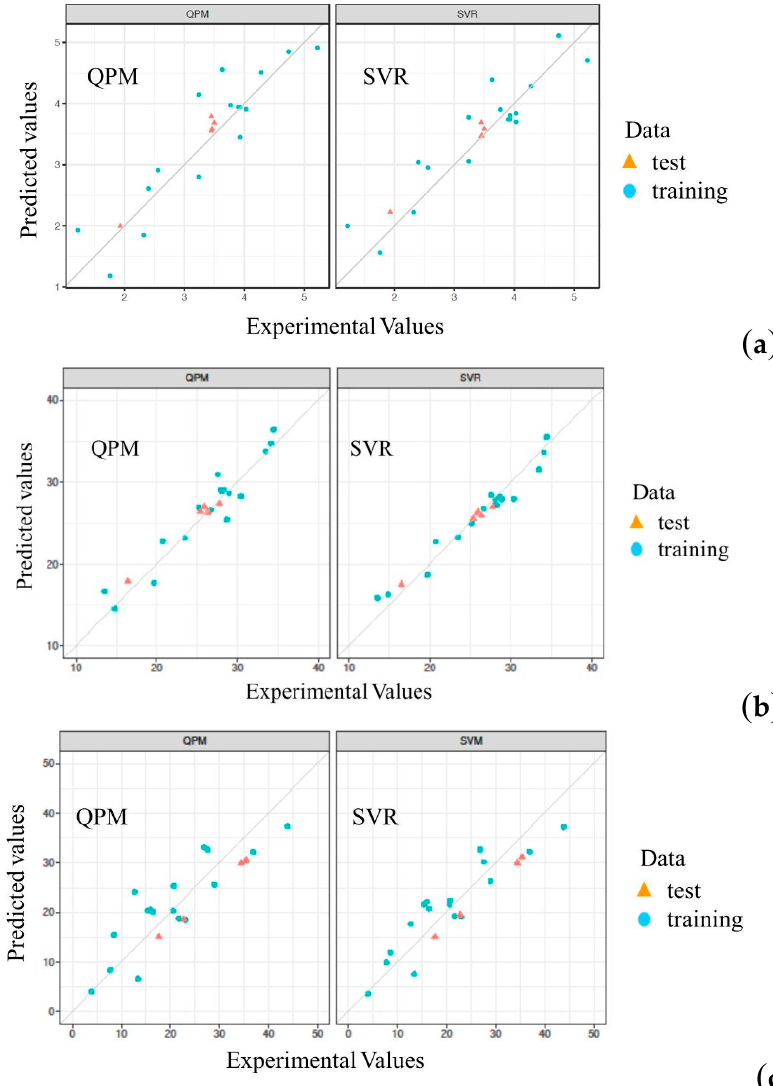
Figure 2. Comparison of predicted and experimental values for QPM and SVR. ( a ) Y 1 ; ( b ) Y 2 ; ( c ) Y 3 .